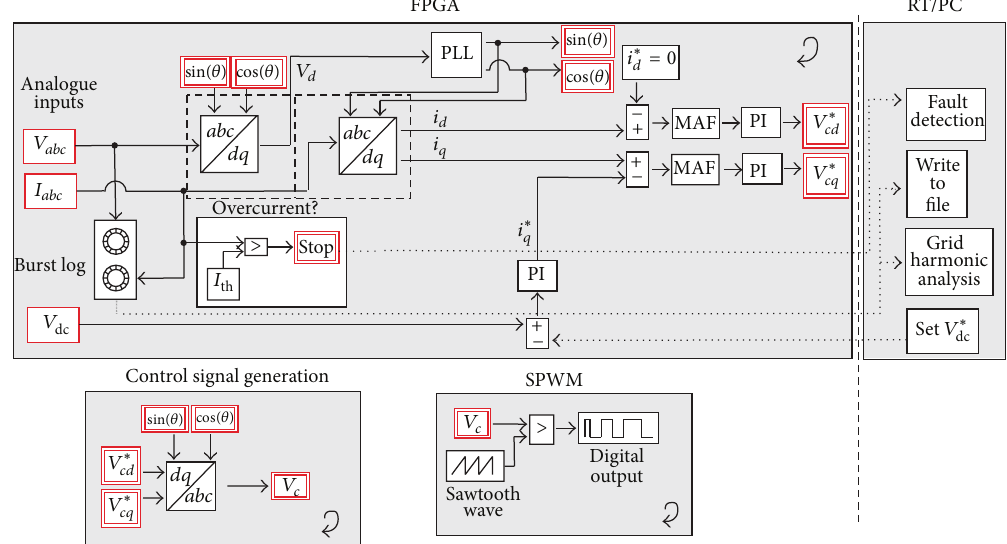
Figure 6: Overview of the FPGA implementation of the grid connection control system.